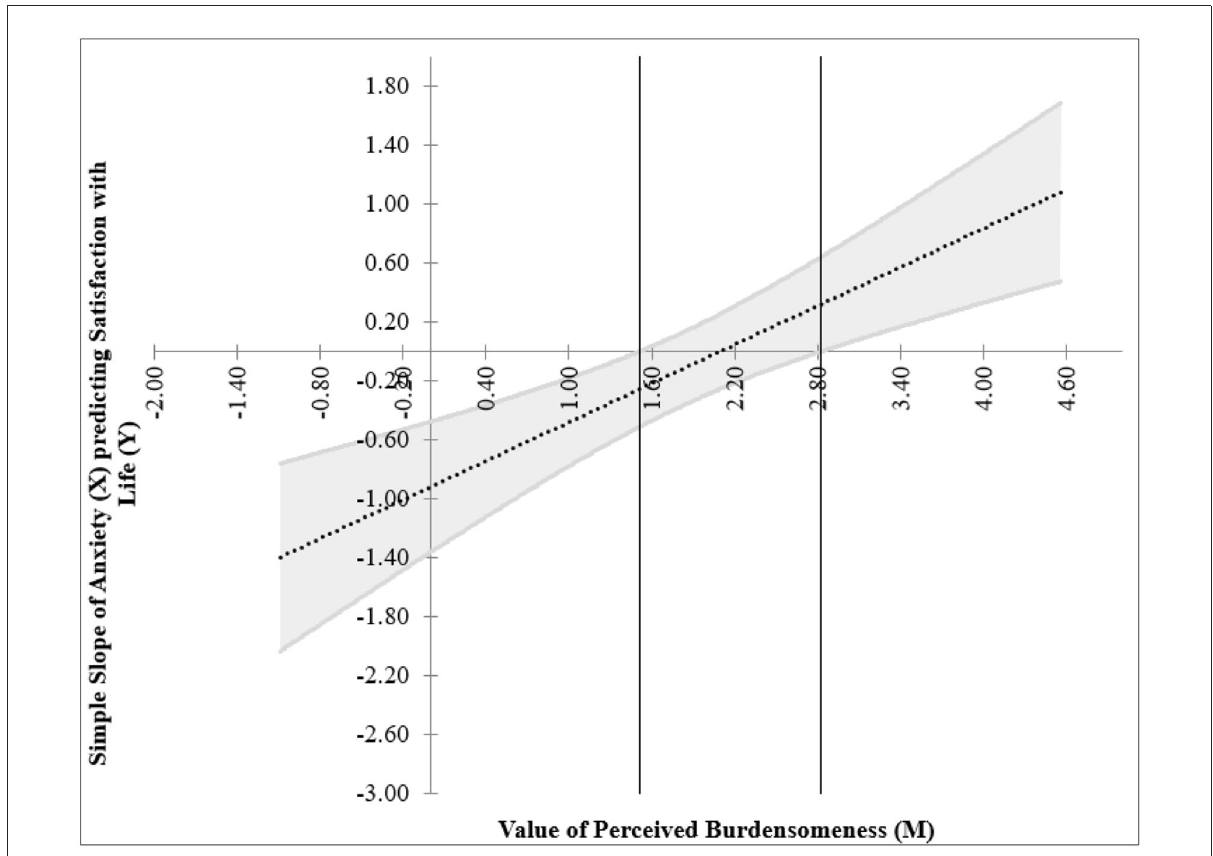
FIGURE4 Johnson–Neyman regions representing the threshold for significant of the effects of focal predictor (anxiety) on the outcome variable (satisfaction with life) for different levels of moderator (perceived